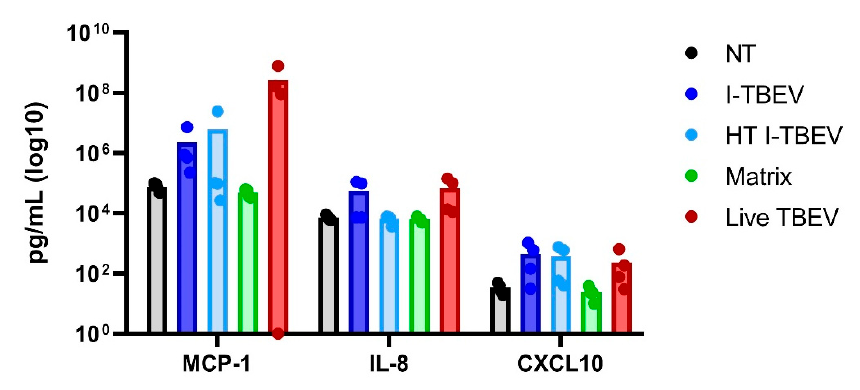
Figure 3. Cytokine production in PBMCs stimulated with conforming, non-conforming I-TBEV and live TBEV. PBMCs from 4 donors were stimulated with the indicated compounds for 24 h, after which the supernatants were collected and the cytokine concentration assessed by Cytometric Bead Assay. Bars represent the average value and dots the individual value per donor.